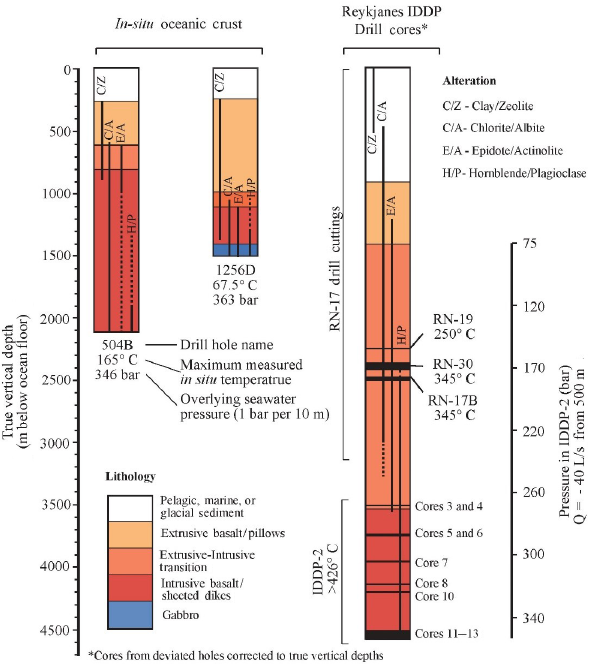
Figure 6. Simplified alteration and lithology logs of RN-15/IDDP- 2 compared to the two deepest DSDP/ODP/IODP drill holes com- pleted in situ oceanic crust (Hole 504B and Hole 1256D). Maxi- mum temperature and pressure conditions are indicated. The struc- ture of the Reykjanes geothermal system differs from 504B and 1256D in that the transition zone between the upper pillow basalt section and lower sheeted dike section is greatly expanded at Reyk- janes. On a broad scale, alteration mineral sequences in the active Reykjanes system vary predictably as a function of depth in the crust and temperature. Overprinting alteration mineral sequences in rocks from Holes 504B and 1256D reflect time-integrated changes in hydrothermal conditions as rocks tectonically migrated away from active hydrothermal conditions at the spreading center. Data for DSDP/ODP/IODP holes from Alt et al. (2010); Anderson et al. (1982); and Marks et al. (2010). Data for shallower portions of Reykjanes from Marks et al. (2010); Fowler et al. (2015); and Fowler and Zierenberg